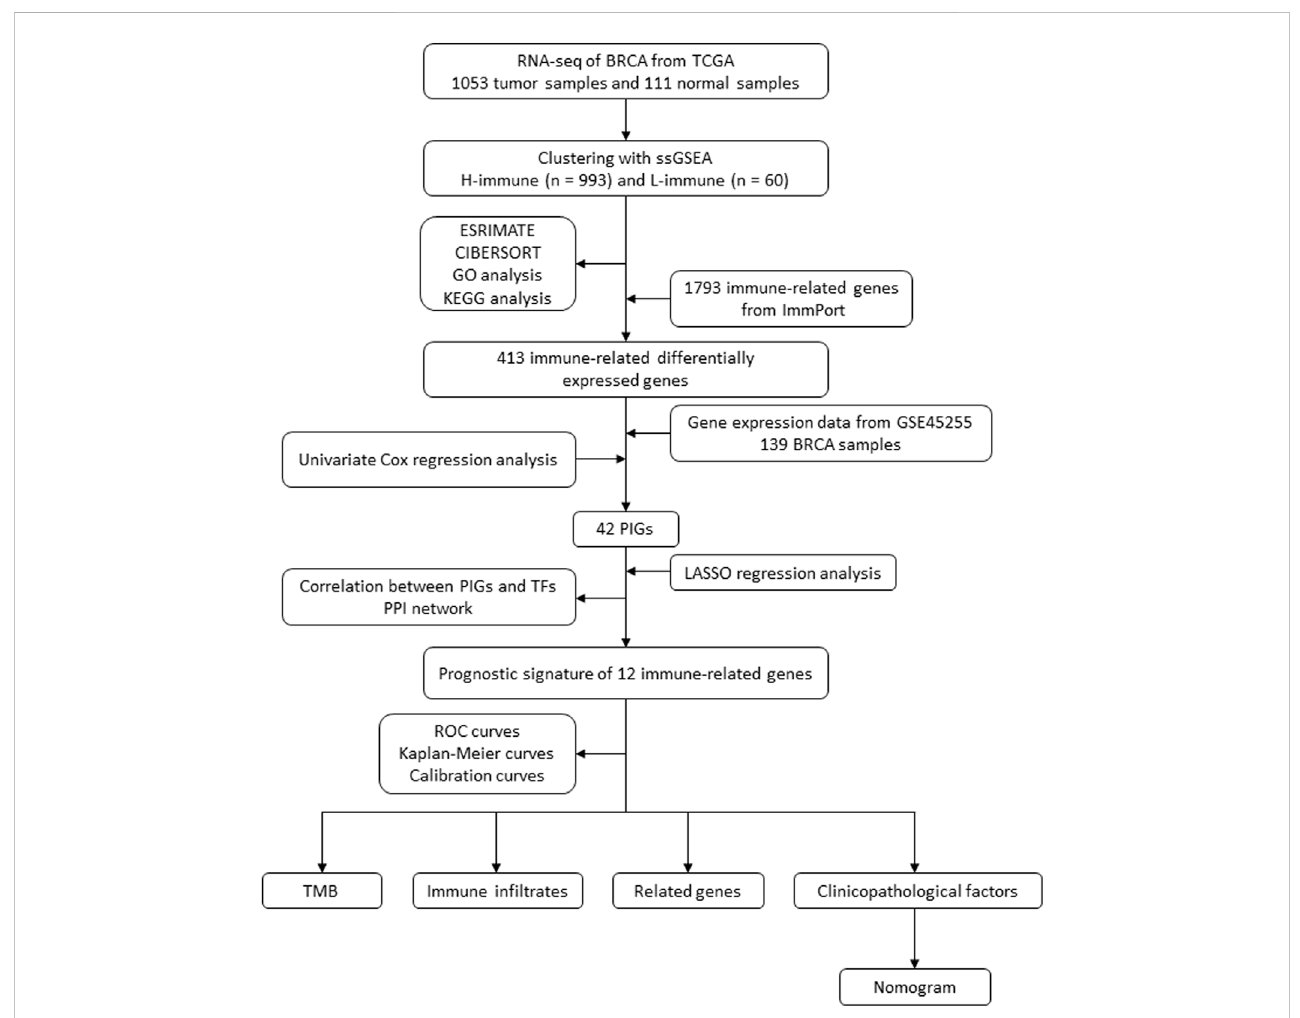
FIGURE 1 Flow diagram of the study. BRCA, breast cancer; TCGA, The Cancer Genome Atlas; ssGSEA, single-sample gene set enrichment analysis; KEGG, Kyoto Encyclopedia of Genes and Genomes; GO, Gene Ontology; PIG, prognostic immune-related gene; LASSO, least absolute shrinkage and selection operator; TF, transcription factor; PPI, protein – protein interaction; ROC, receiver operating characteristic; TMB, tumor mutational